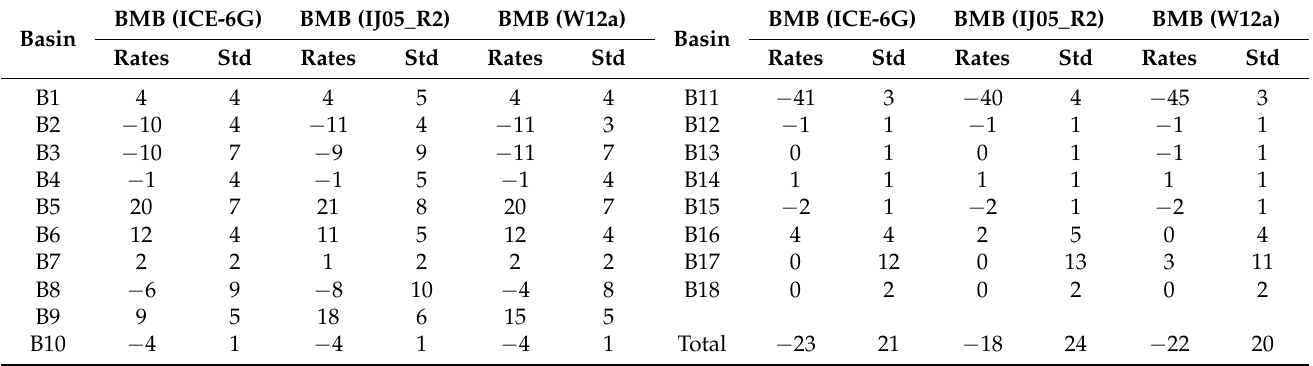
Table 1. Regional BMB rates in 18 drainage basins and associated standard deviations, in